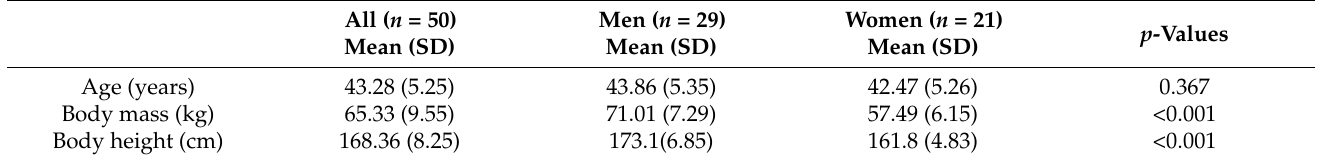
Figure 1. Heart rate (HR) profile at rest, during exercise and during recovery time. RHR: resting heart rate; HRR: heart rate recovery; Δ HRex: Increased heart rate during exercise. Table 1. Age, anthropometric characteristic of participants and 3-km performance according to